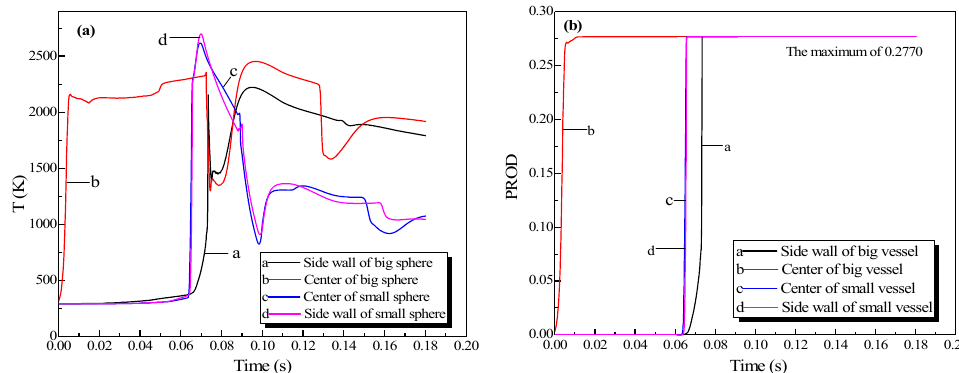
Figure 11. Profiles of the natural gas explosion parameters (temperature and concentration of products versus time) in the big vessel connected to the small vessel. ( a ) Profiles of explosion temperatures against time in the vessels; ( b ) concentration profiles against time for the explosion products in the vessels.